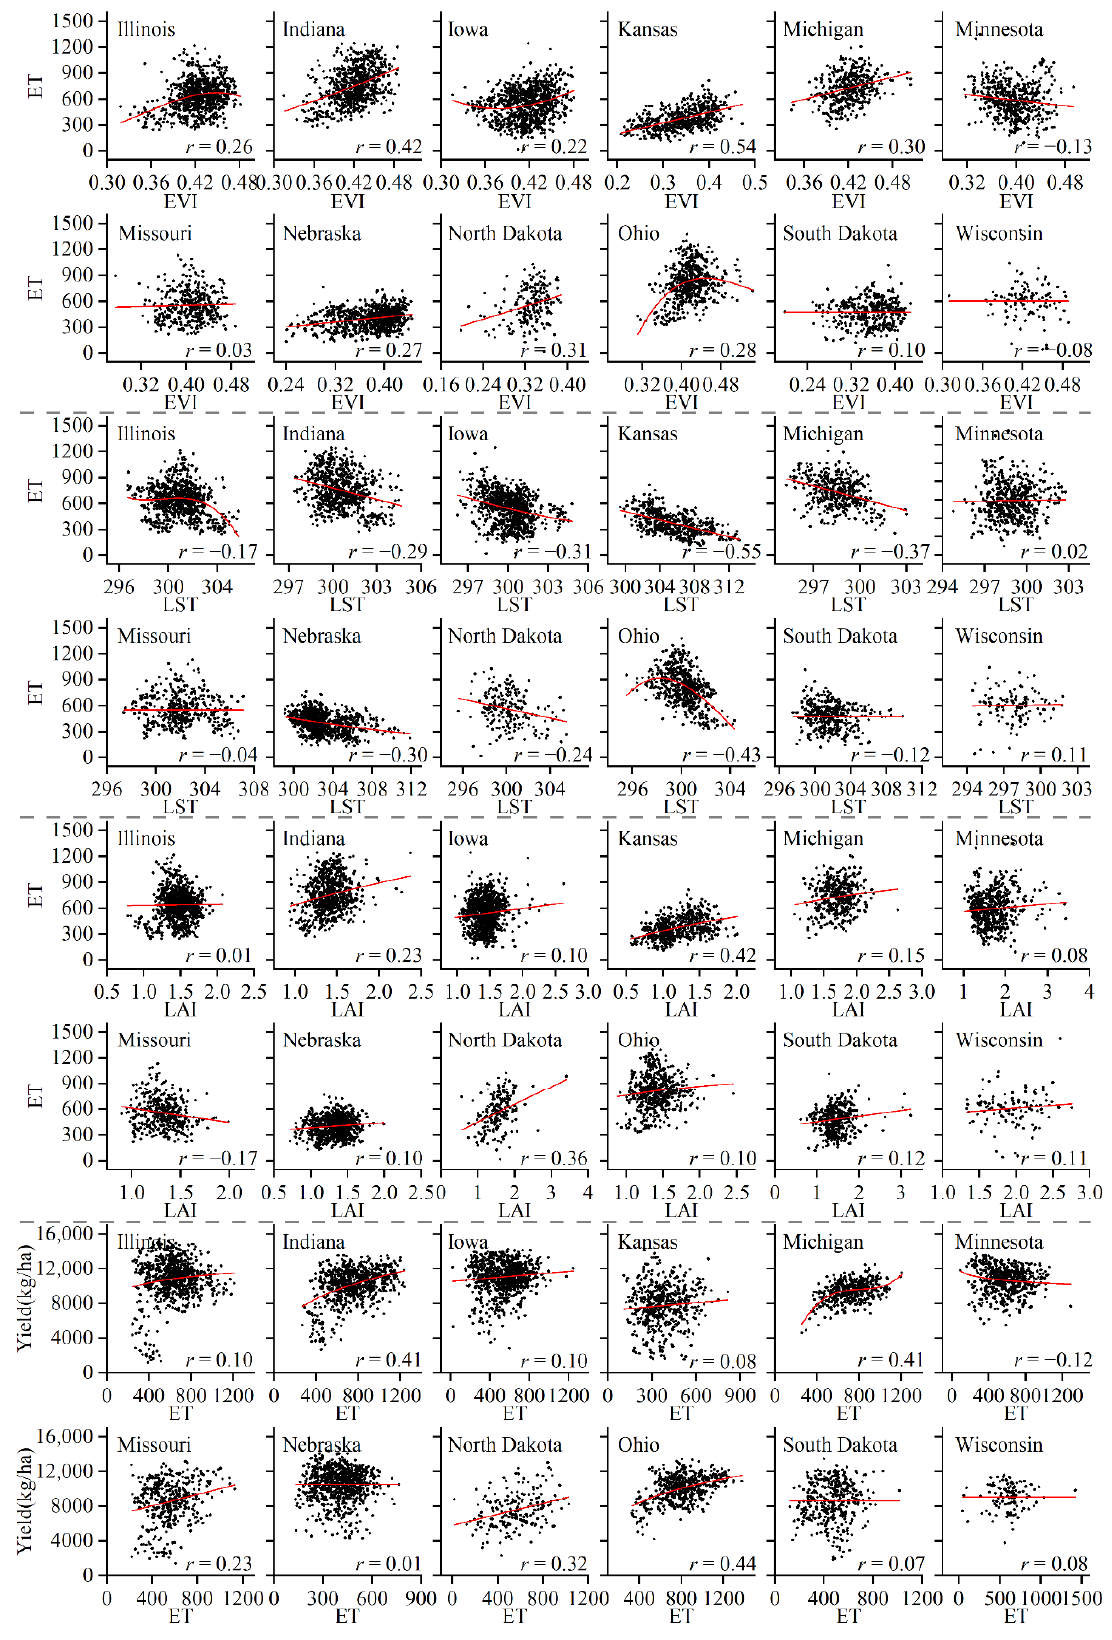
Figure 3. The relationships between the three indices and ET and the relationship between ET and corn yield in different states.